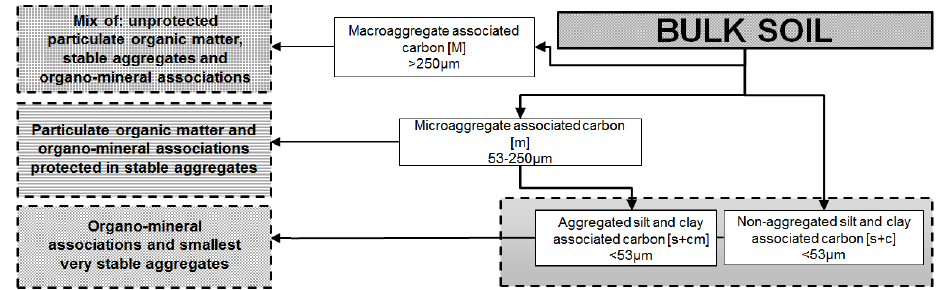
Figure 1. The resulting fractions of the applied fractionation scheme and interpretation of the present carbon stabilization mechanisms in each